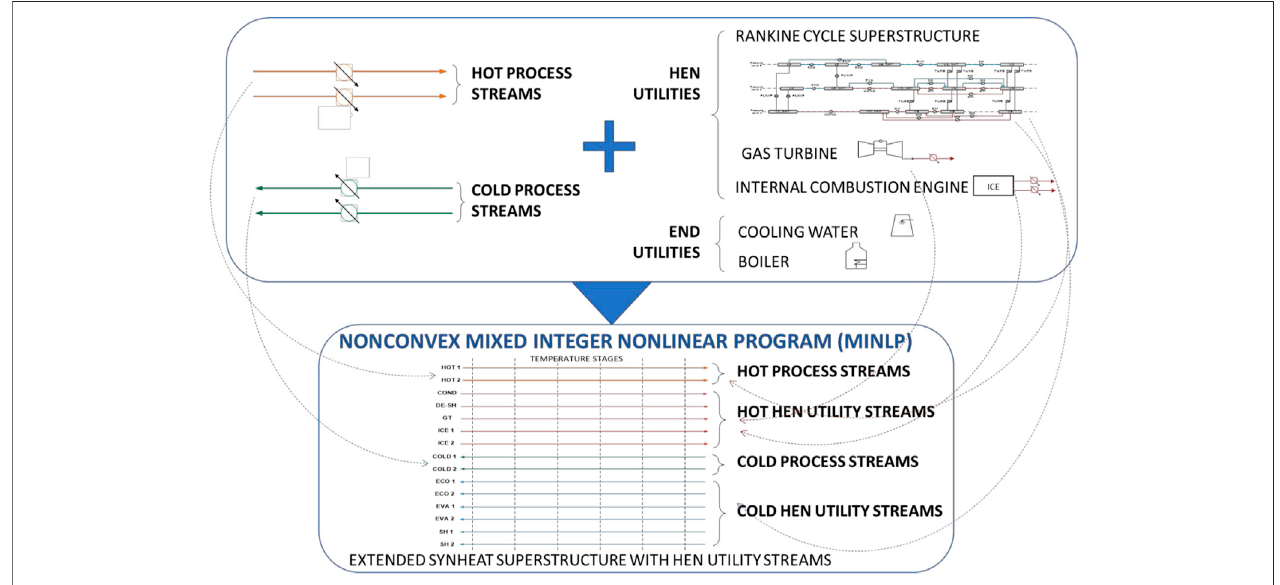
FIGURE7| Integratedsuperstructure ofRankine (steam)cycle,utilitysystems(boilers, coolingwater,gasturbines,etc),andheatexchangernetworkproposedby Elsido et al. (2019). for the design optimization of non-conventional steam cycles and steam networks (source Elsido et al., 2019).